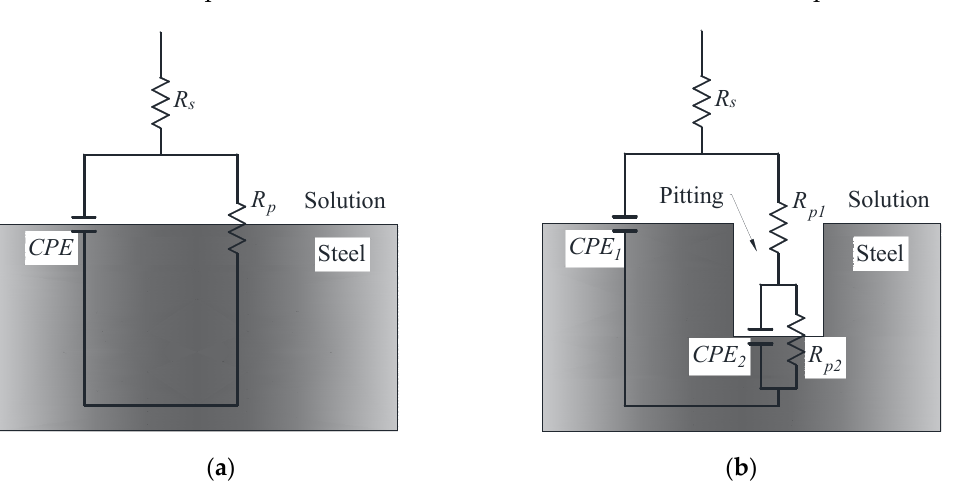
Figure 4. Electrochemical equivalent circuit for the corrosion system: ( a ) without sand, ( b ) with 2 wt% sand.